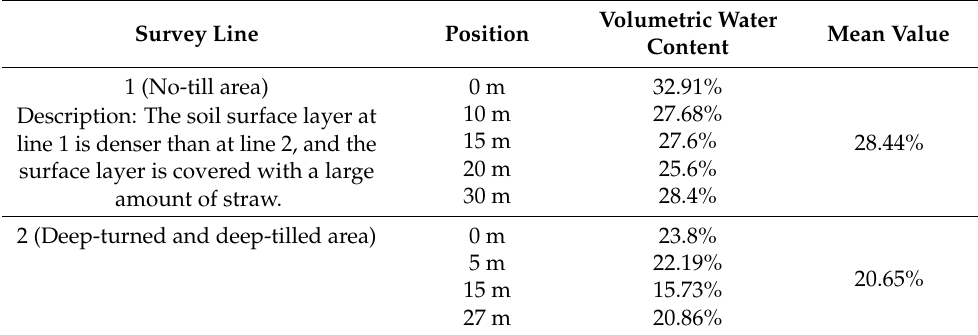
Table 4. Detailed information about TDR soil probe samples.